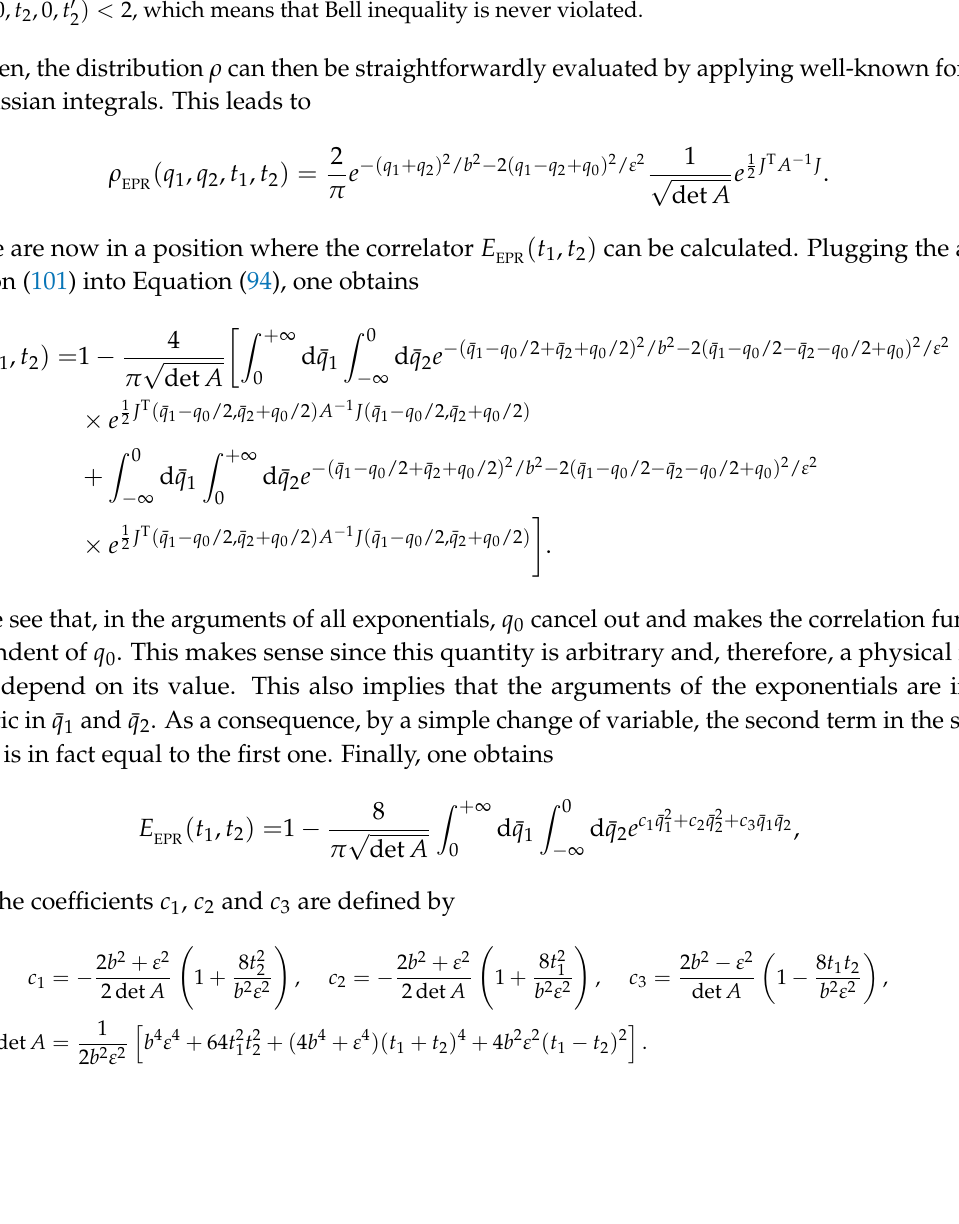
) as a function of the two times t 2 and t (cid:48) Figure 4. Bell quantity B ( 0, t 2 ,0, t (cid:48) 2 a state which has a positive definite Wigner function. As is apparent from the plot, one always has ) < 2, which means that Bell inequality is never B ( 0, t 2 ,0, t (cid:48) 2